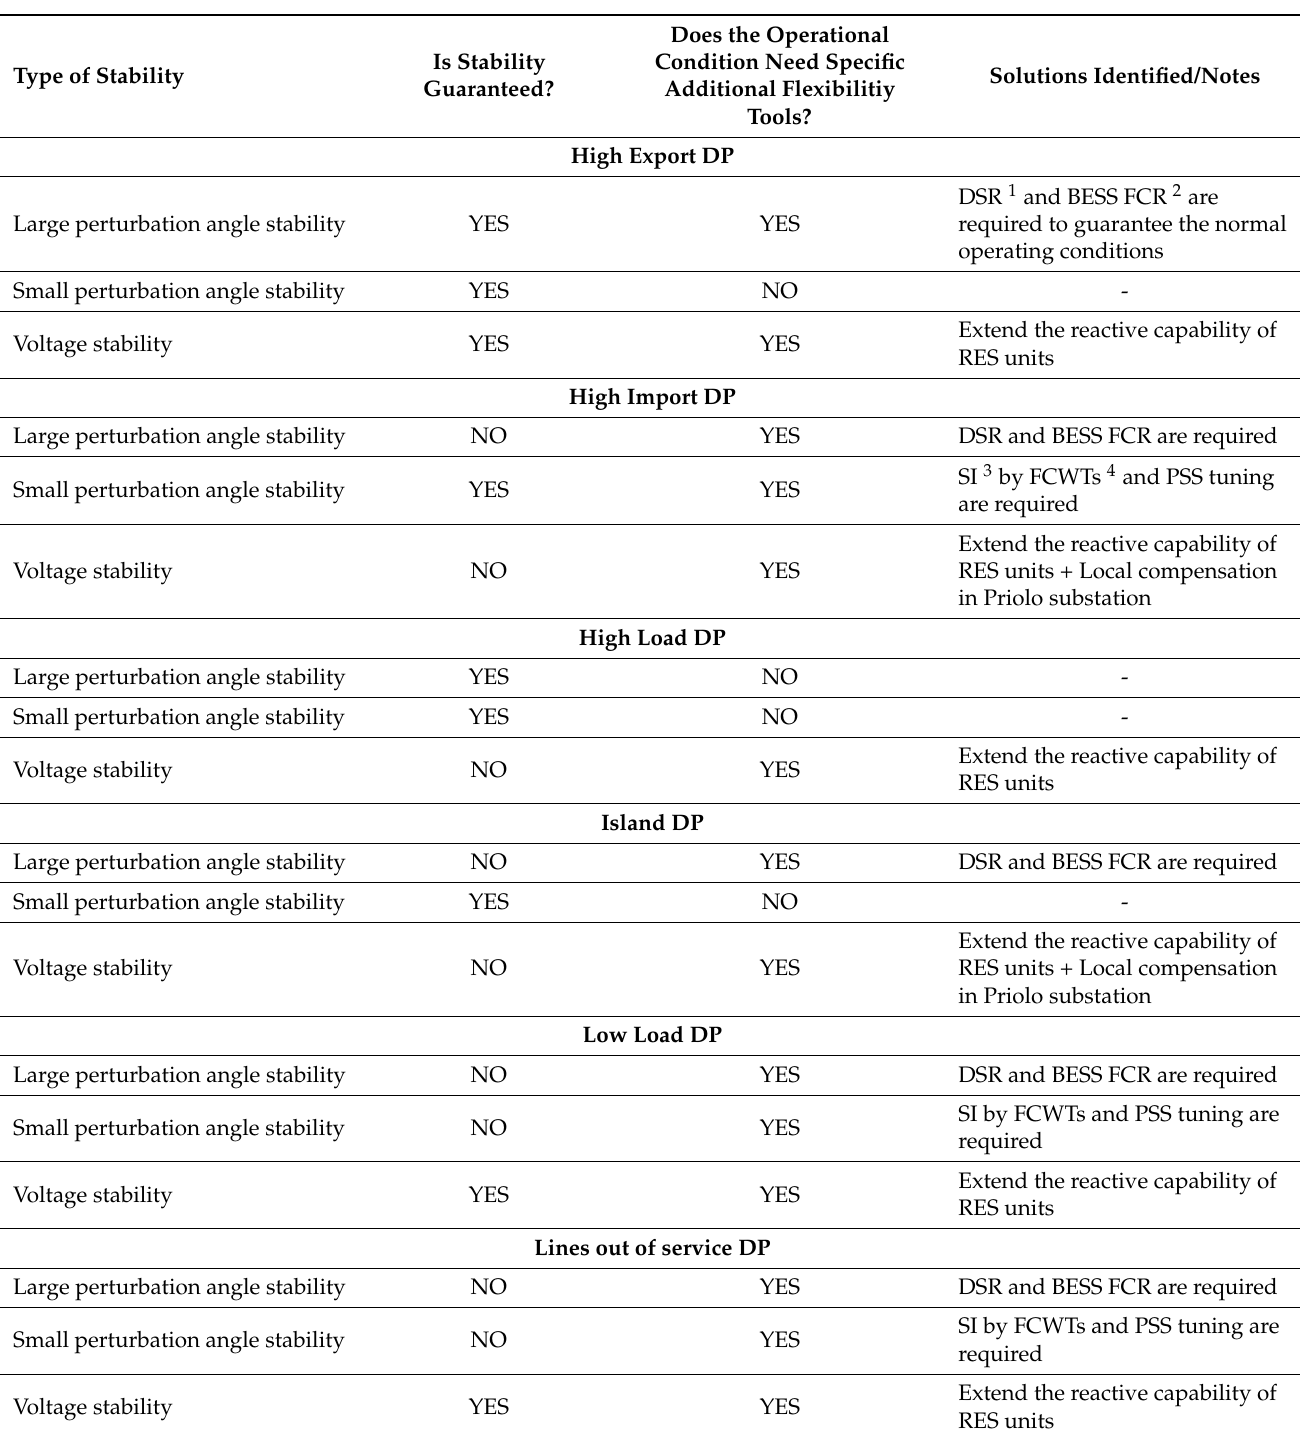
Table 24. Conclusions